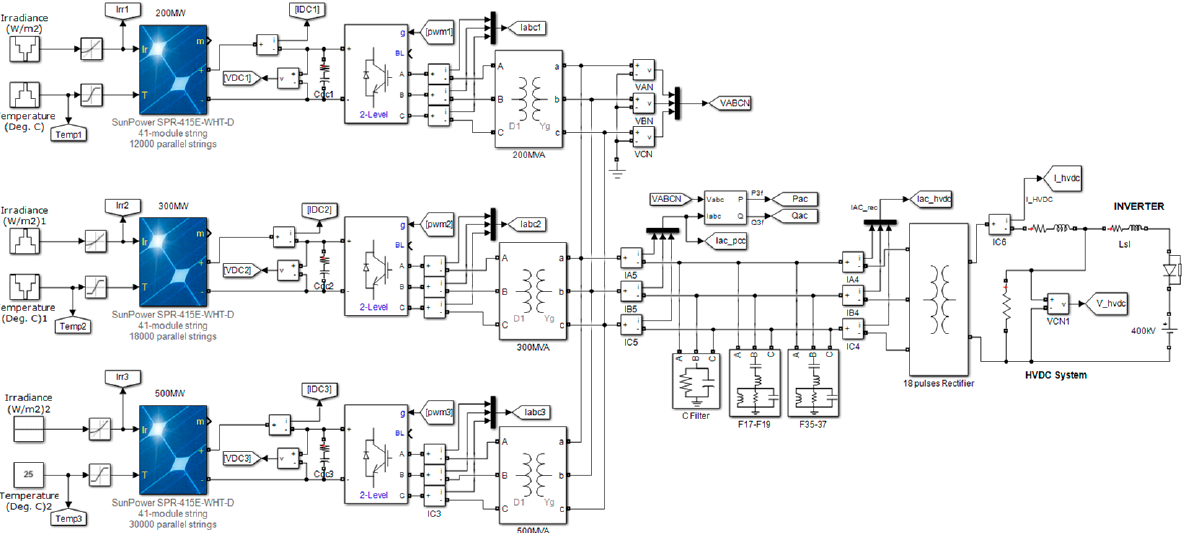
Figure 7. The simulated PV generation system.